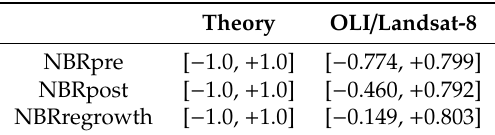
Table 3. Theory and observed bands, considering the pixels corresponding to the NBR indices for the Gerais do Vieira Gerais do Vieira fire.